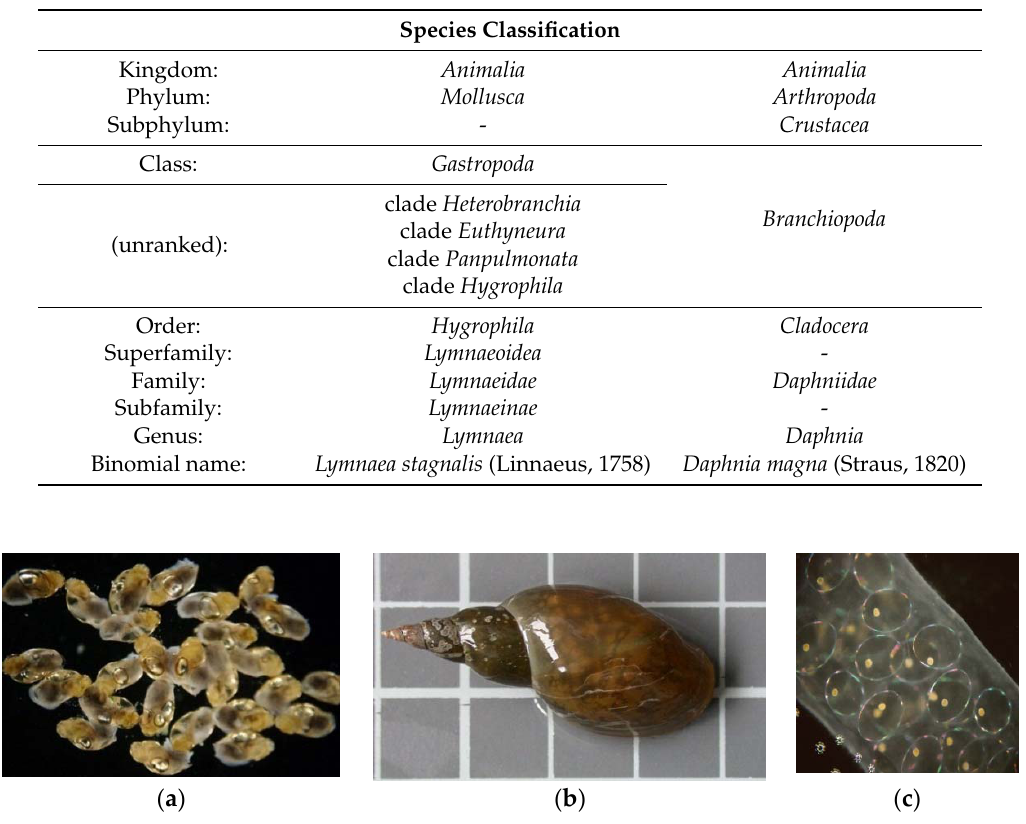
Table 1. Lymnaea stagnalis and Daphnia magna classification.